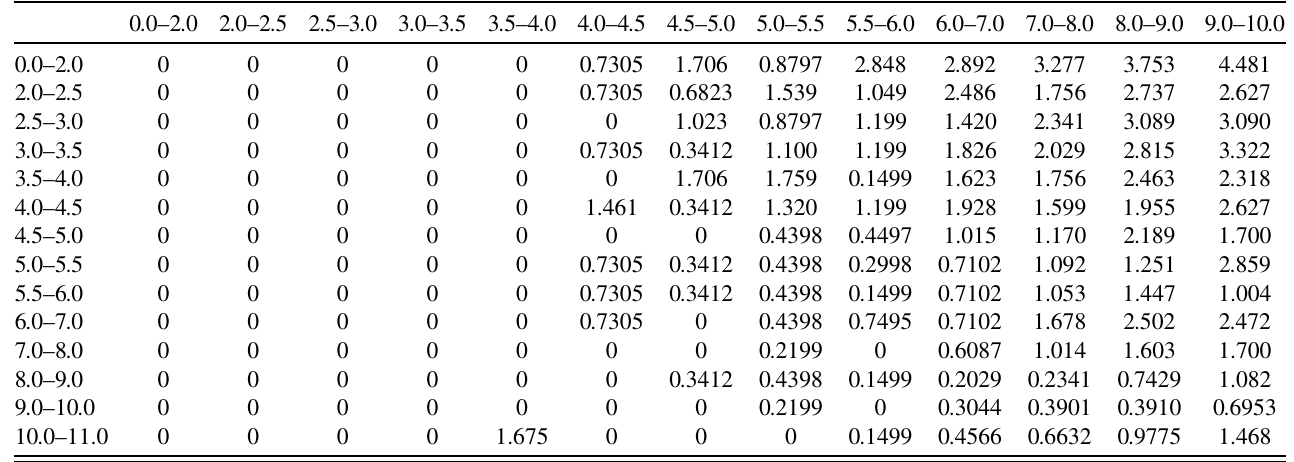
TABLE XIX. (cid:4) þ background from (cid:3) (cid:5) CC events (all values (cid:2) 10 (cid:1) 4 ).